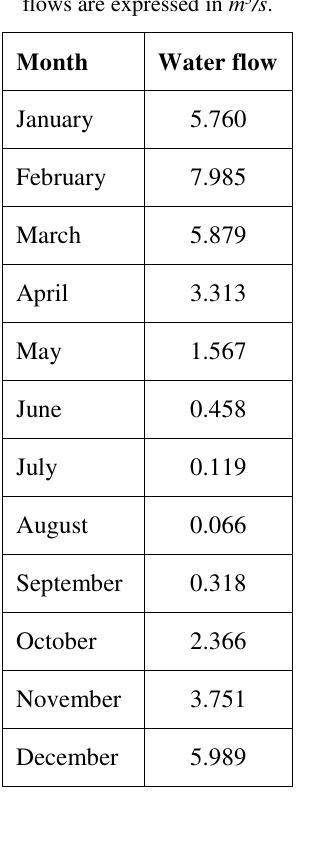
Table 1. Monthly water flows in the investigated river. Water flows are expressed in m 3 /s .